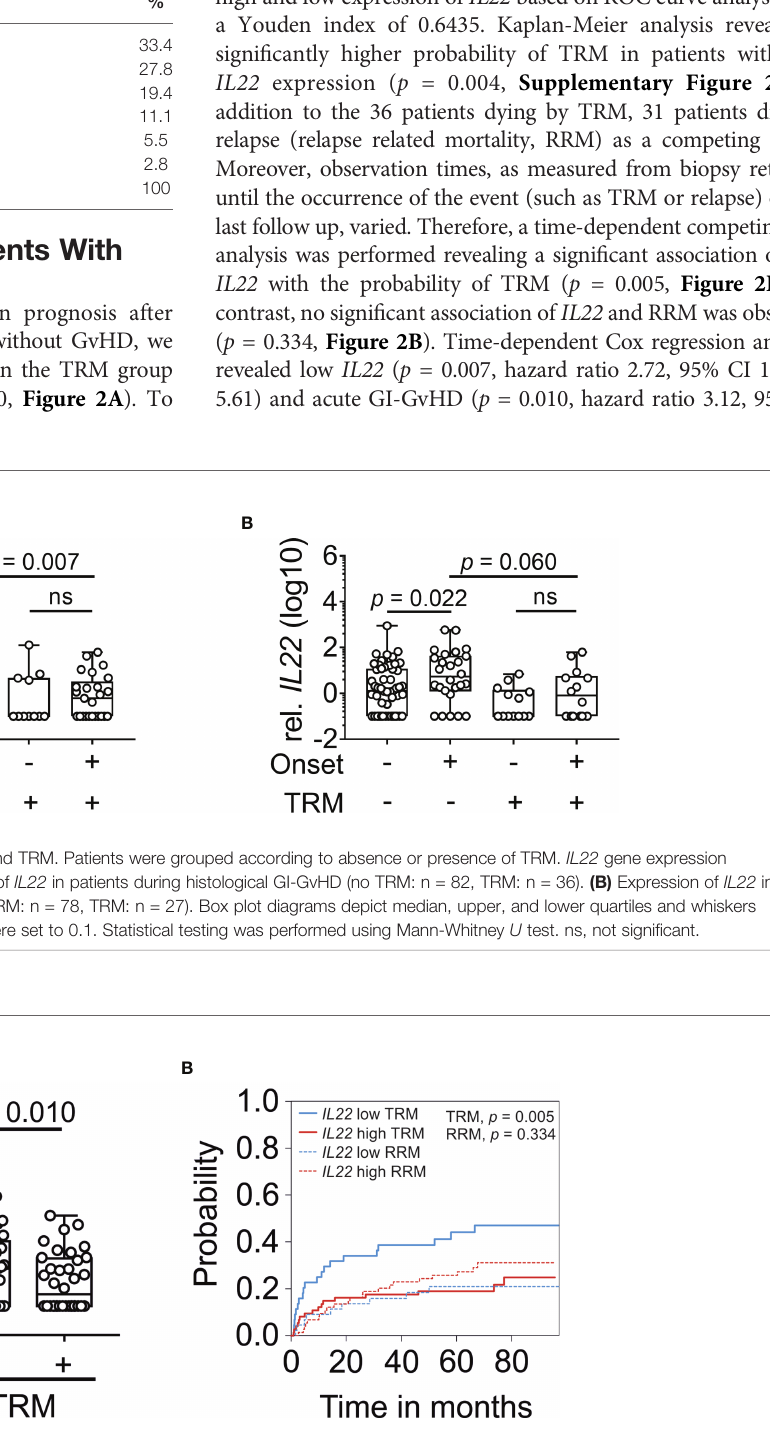
FIGURE 2 | IL22 expression with respect to TRM. (A) IL22 gene expression in patients grouped according to absence or presence of TRM without further subgrouping (non-TRM: n = 82, TRM: n = 36). IL22 gene expression was normalized to 18s rRNA . Box plot diagrams depict median, upper, and lower quartiles and whiskers indicate minimal and maximal values. Negative values were set to 0.1. Statistical testing was performed using Mann-Whitney U test. (B) Association of IL22 with cumulative incidence function estimates for competing risk data. Patients were dichotomized in accordance to high (red line) and low expression (blue line) of IL22 based on Youden index. The cumulative risk of TRM and RRM in dependence of the months after biopsy is shown.